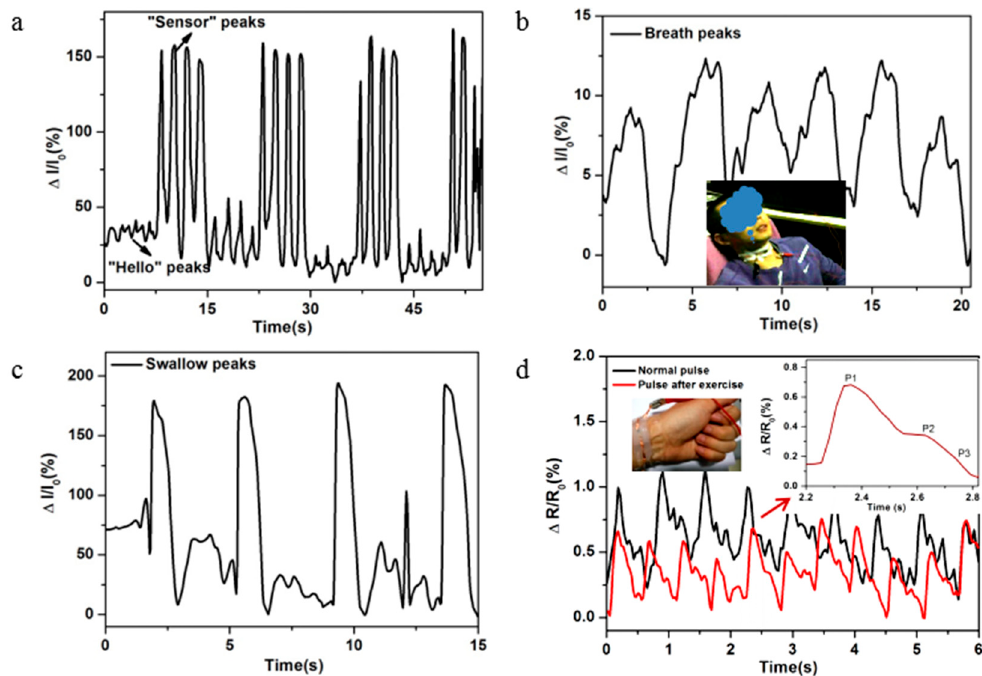
Figure 5. ( a ) The relative resistance changes of the wearable sensor at input voltage of 4 V when the wearer said “Hello” and “sensor”. ( b ) The relative resistance changes of the wearable sensor at input voltage of 4 V when wearer took a breath. Inset: the photograph of wearable sensor on the throat. ( c ) The relative resistance changes of the strain sensor at input voltage of 4 V when wearer swallowed slobber. ( d ) The relative resistance change as a function of time at input voltage of 4 V when monitoring the wrist pulse. Inset: magnified view of one particular waveform.